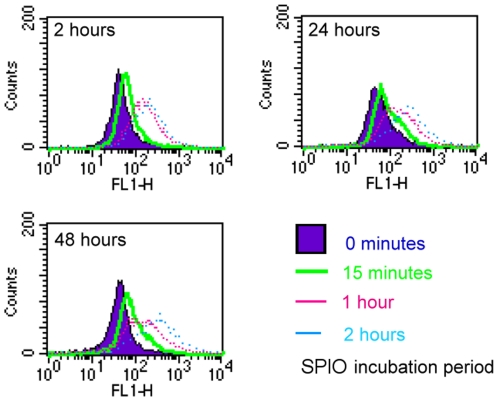
Flow cytometry measurement of ROS production in macrophages after SPIO particle uptake at different time points.The intensity of the fluorescence of the FL-1 channel was linearly correlated to ROS production. ROS increased when the cells were exposed to SPIO particles after 2 h, and this effect lasted up to 48 h. There was also a dose-dependent response when the cells were incubated with SPIO particles for longer periods, indicating that ROS production is related to particle loading.